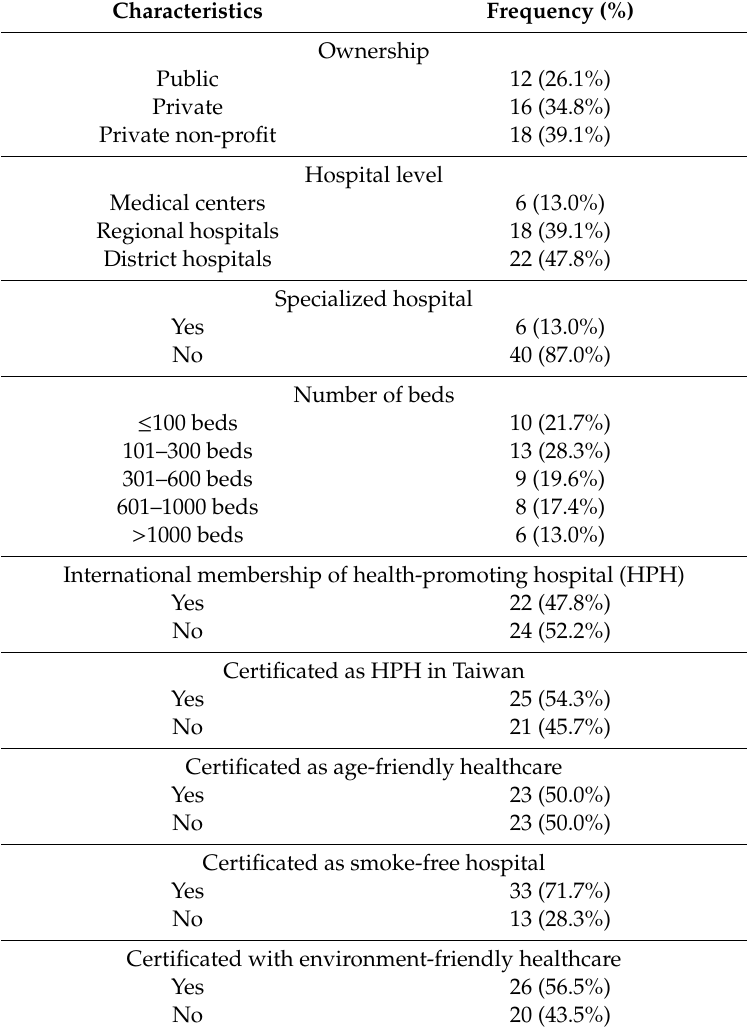
Table 2. Characteristics of participating